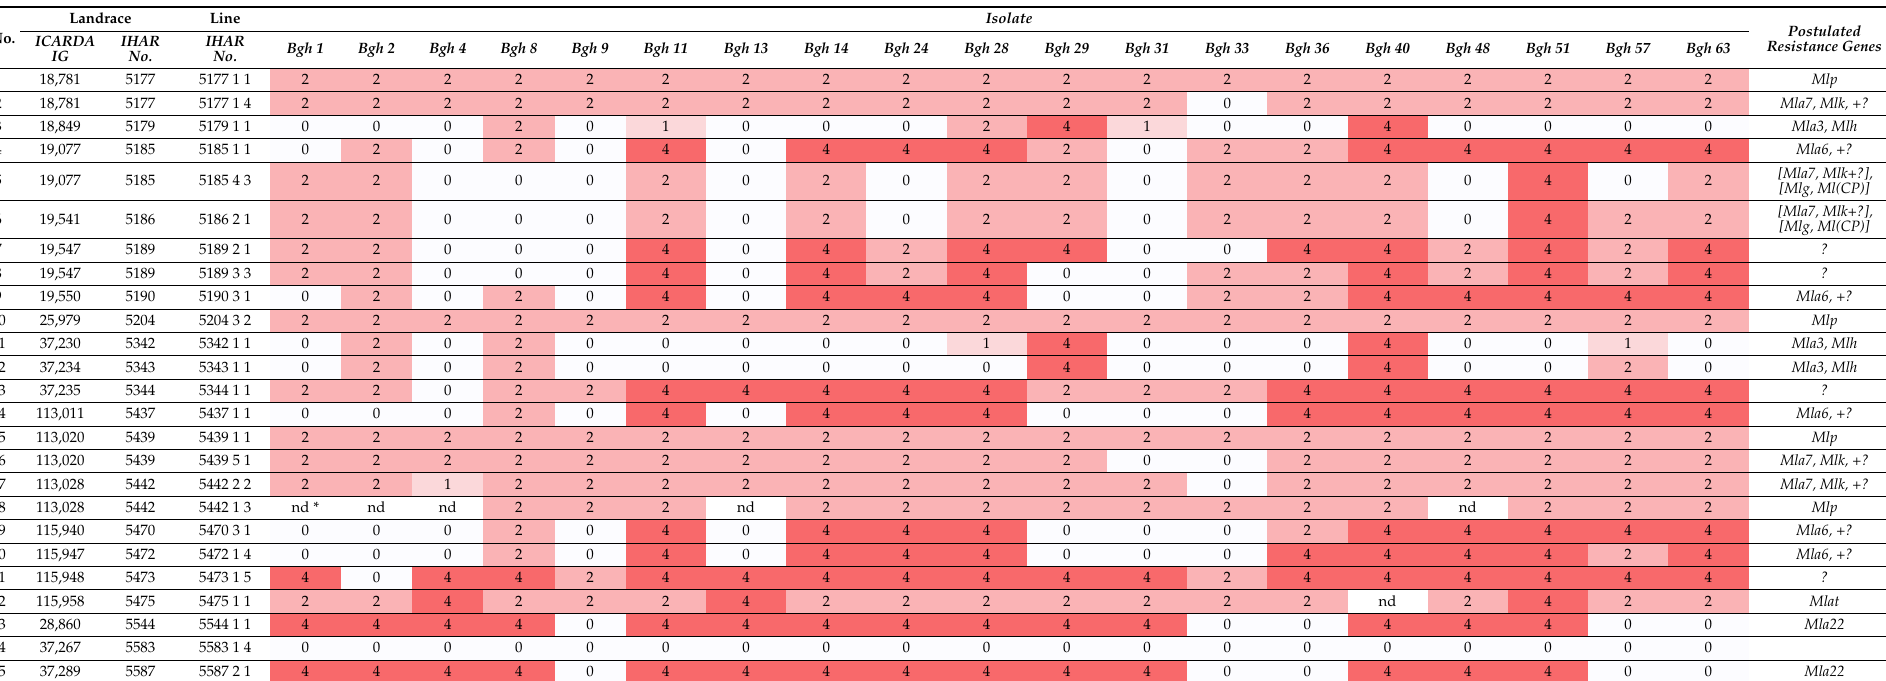
Postulated ResistanceGenesICARDA